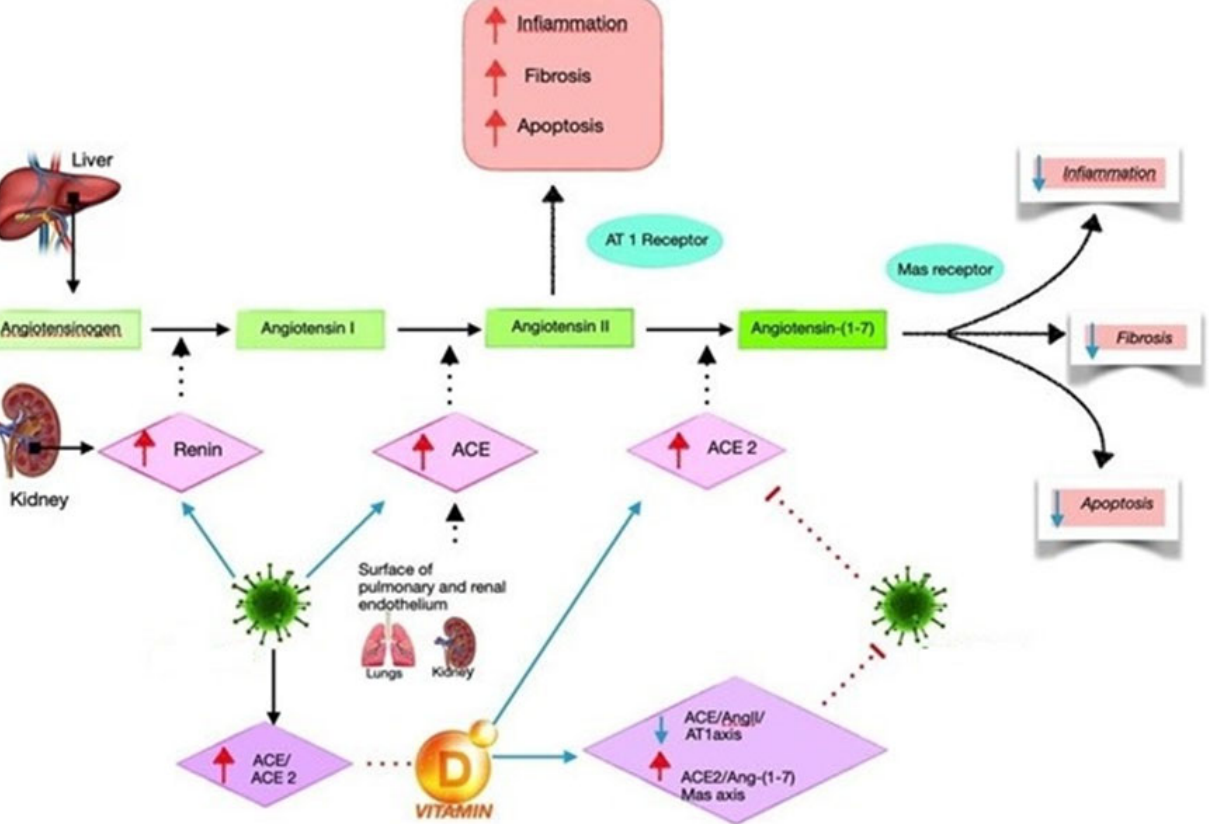
Figure 1. Plausible vitamin D mechanism of action as a negative endocrine modulator of the renin–angiotensin system (RAS). It can induce ACE2/Ang-(1–7)/MasR axis activity and inhibit renin and the ACE/Ang II/AT1R axis, thereby increasing the expression and concentration of ACE2, MasR, and Ang-(1–7) and playing a potential protective role against infectious disease with a reduction of fibrosis and inflammatory effects.